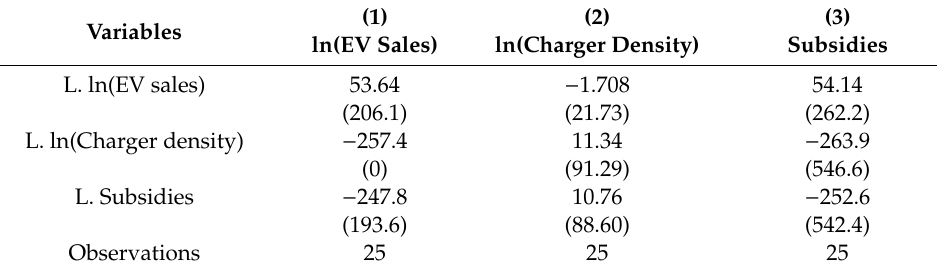
Table 10. Results of the Granger causality